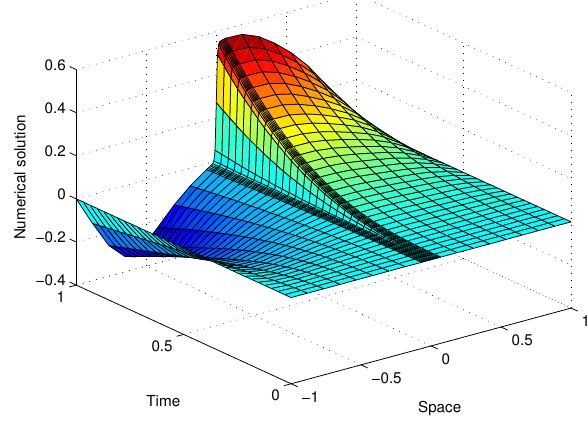
Figure 2. Numerical solution of problem (4.1), (4.2) for ε = 10 − 2 with N = N 0 = 32 on the Shishkin